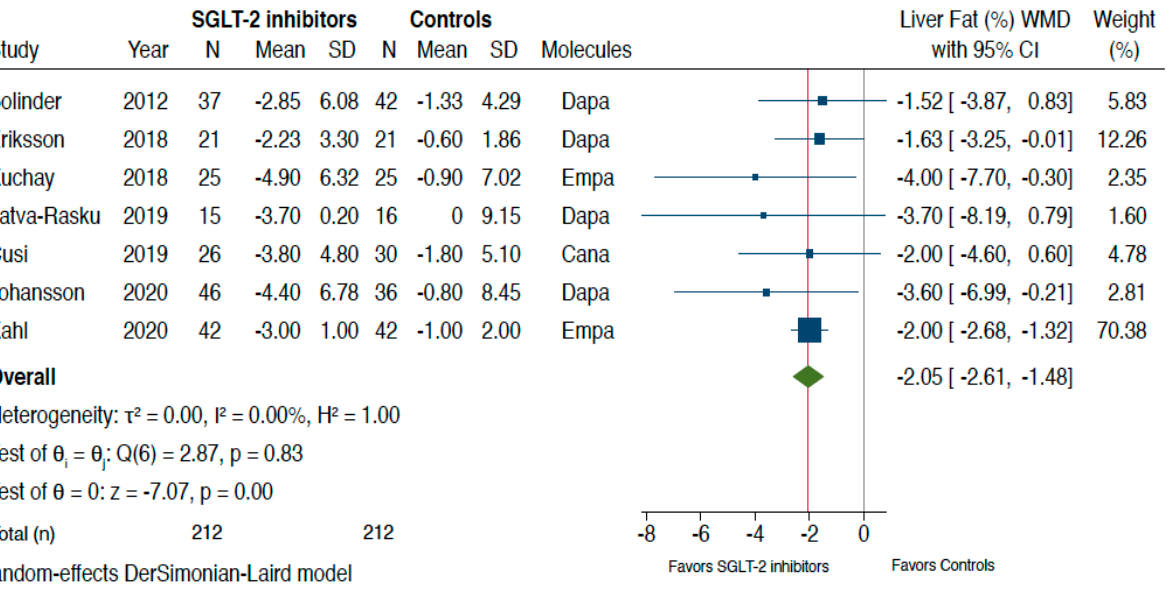
Figure 1. Forest plot of the effect of SGLT-2 inhibitors on serum liver enzyme levels (i.e., serum alanine aminotransferase (ALT) ( n = 9 randomized controlled trials (RCTs), panel A ), aspartate aminotransferase (AST) ( n = 9 RCTs, panel B ), and gamma-glutamyltransferase (GGT) ( n = 6 RCTs, panel C )) as compared with placebo or reference therapy. The pooled (green diamond) and individual effect sizes for RCTs included were expressed as weighted mean difference (WMD) and 95% confidence intervals (CI). Note: If not available, the SDs of the weighted mean difference were estimated using a specific formula (as reported in the Methods section).